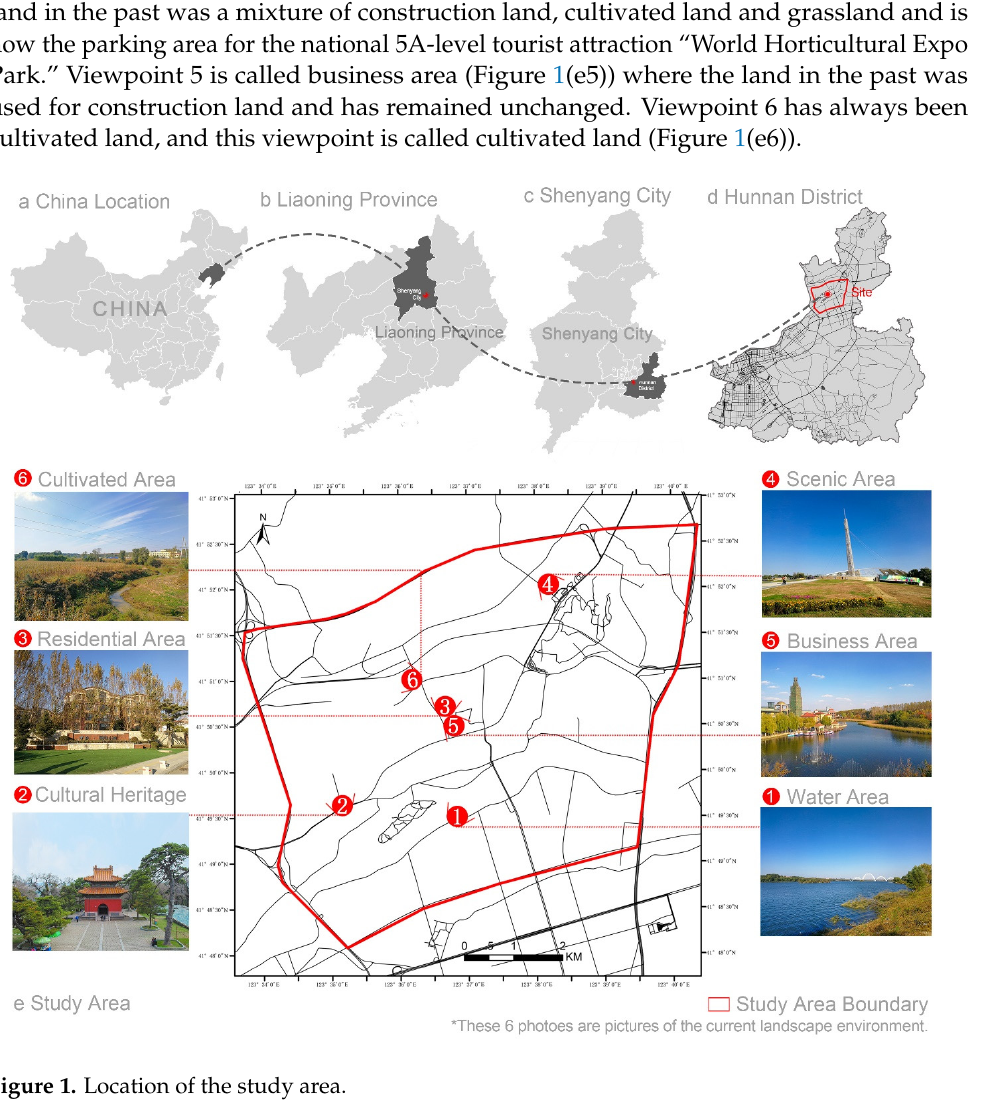
Figure 1. Location of the study area.